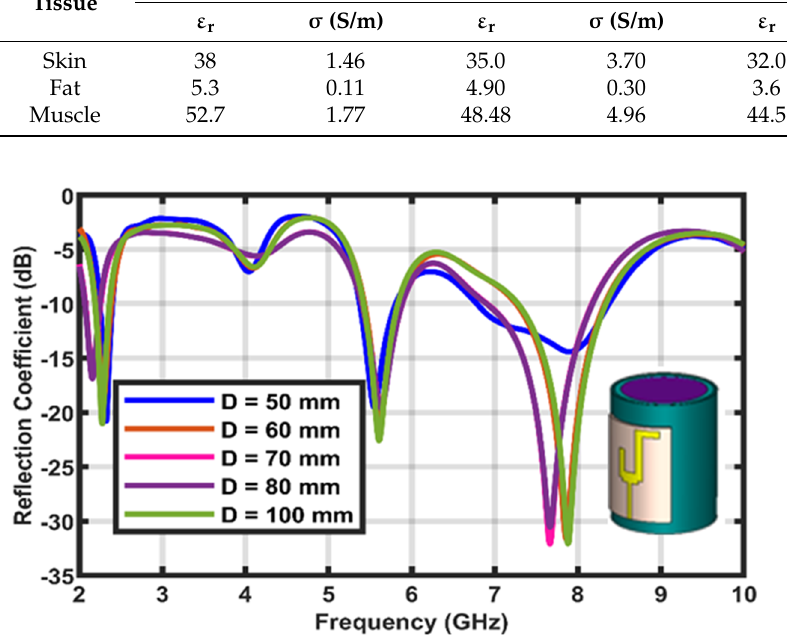
Figure 18. Effect of bending the antenna over different diameters.